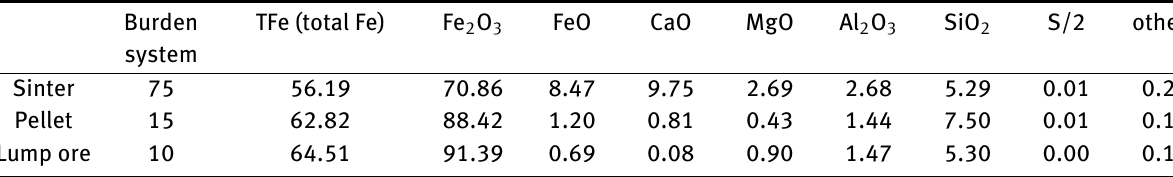
Table 2: Components of coke and pulverized coal (mass%). Fixed Ash carbon SiO 2 Coke Coal